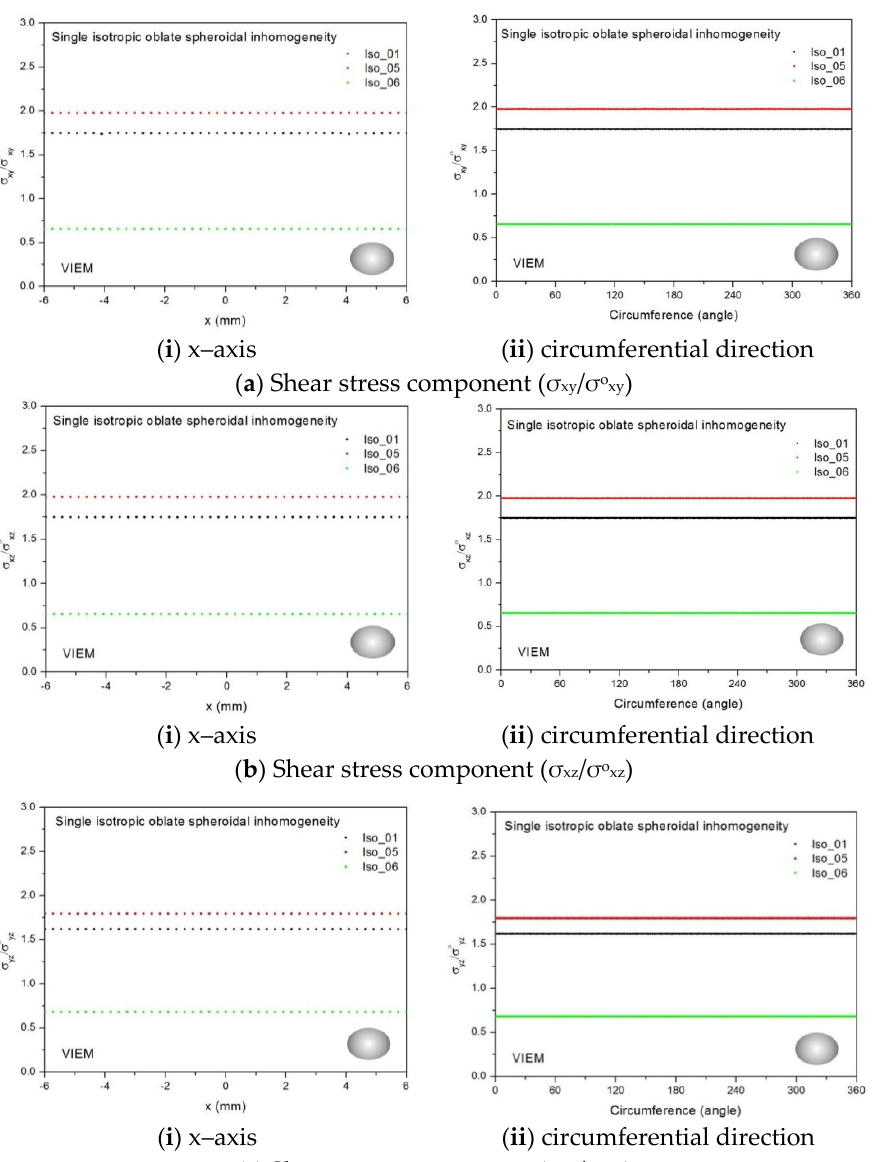
Figure 29. VIEM results for the normalized shear stress components ( a ) σ xy / σ oxy , ( b ) σ xz / σ oxz and ( c ) σ yz / σ oyz along ( i ) the x–axis inside and ( ii ) the circumferential direction of the isotropic oblate sphe- roidal inclusions (Iso_01, Iso_05 and Iso_06) with b/a = c/a = 0.5 (a = 6 mm) under remote shear loading ( σ oxy , σ oxz and σ oyz ).